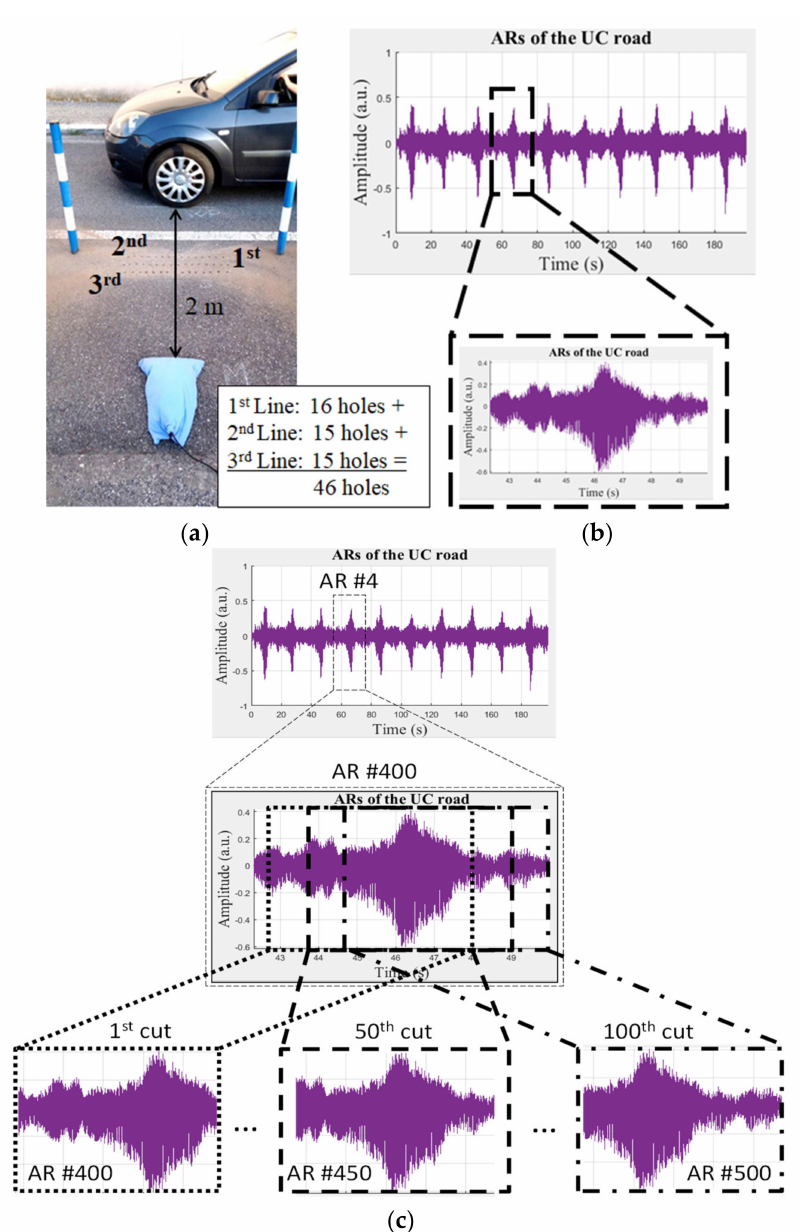
Figure 2. Experimental set up: ( a ) microphone attached 2 m far the car pass-by and three lines of drilled holes, ( b ) acoustic responses, ARs, of the un-cracked, UC, road pavement to the car’s loads, and ( c ) schematic representation of the augmentation procedure used in this